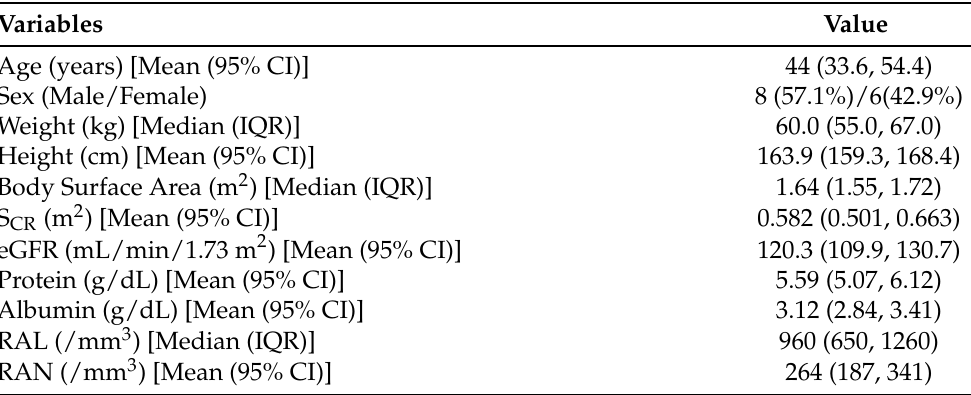
Table 1. Characteristics of patients in the study